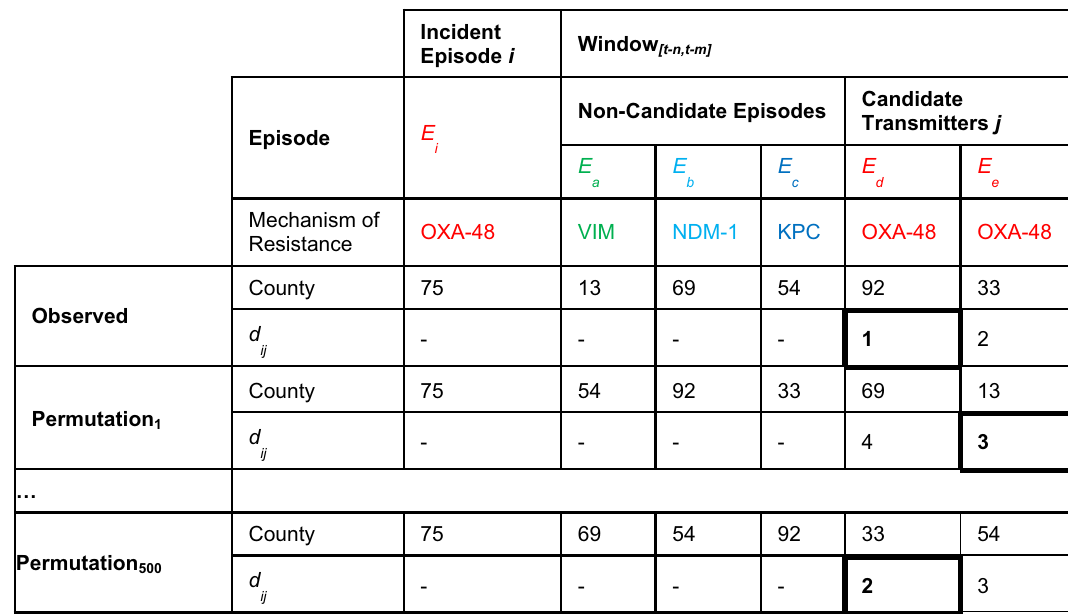
Table 3. Example of potential infector selection in the observed data and